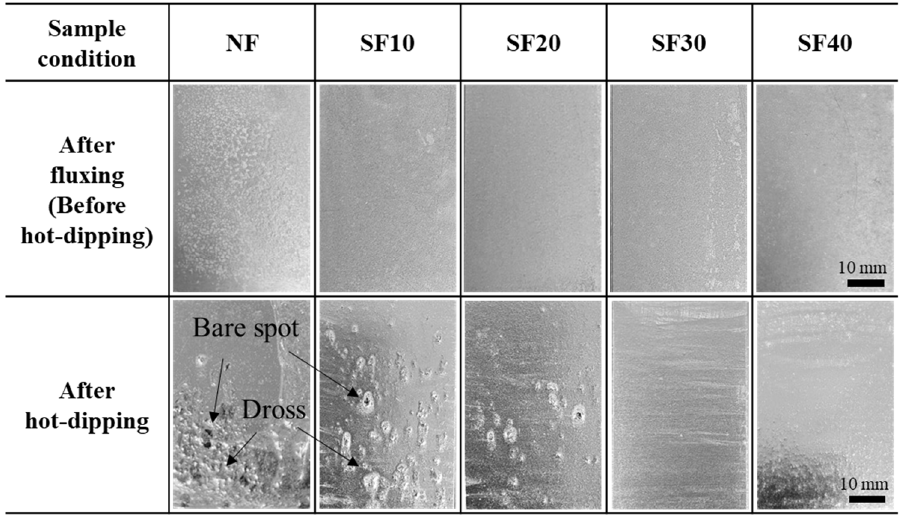
Figure 1. Surface of the samples before and after hot dipping with the respective flux composi ‐